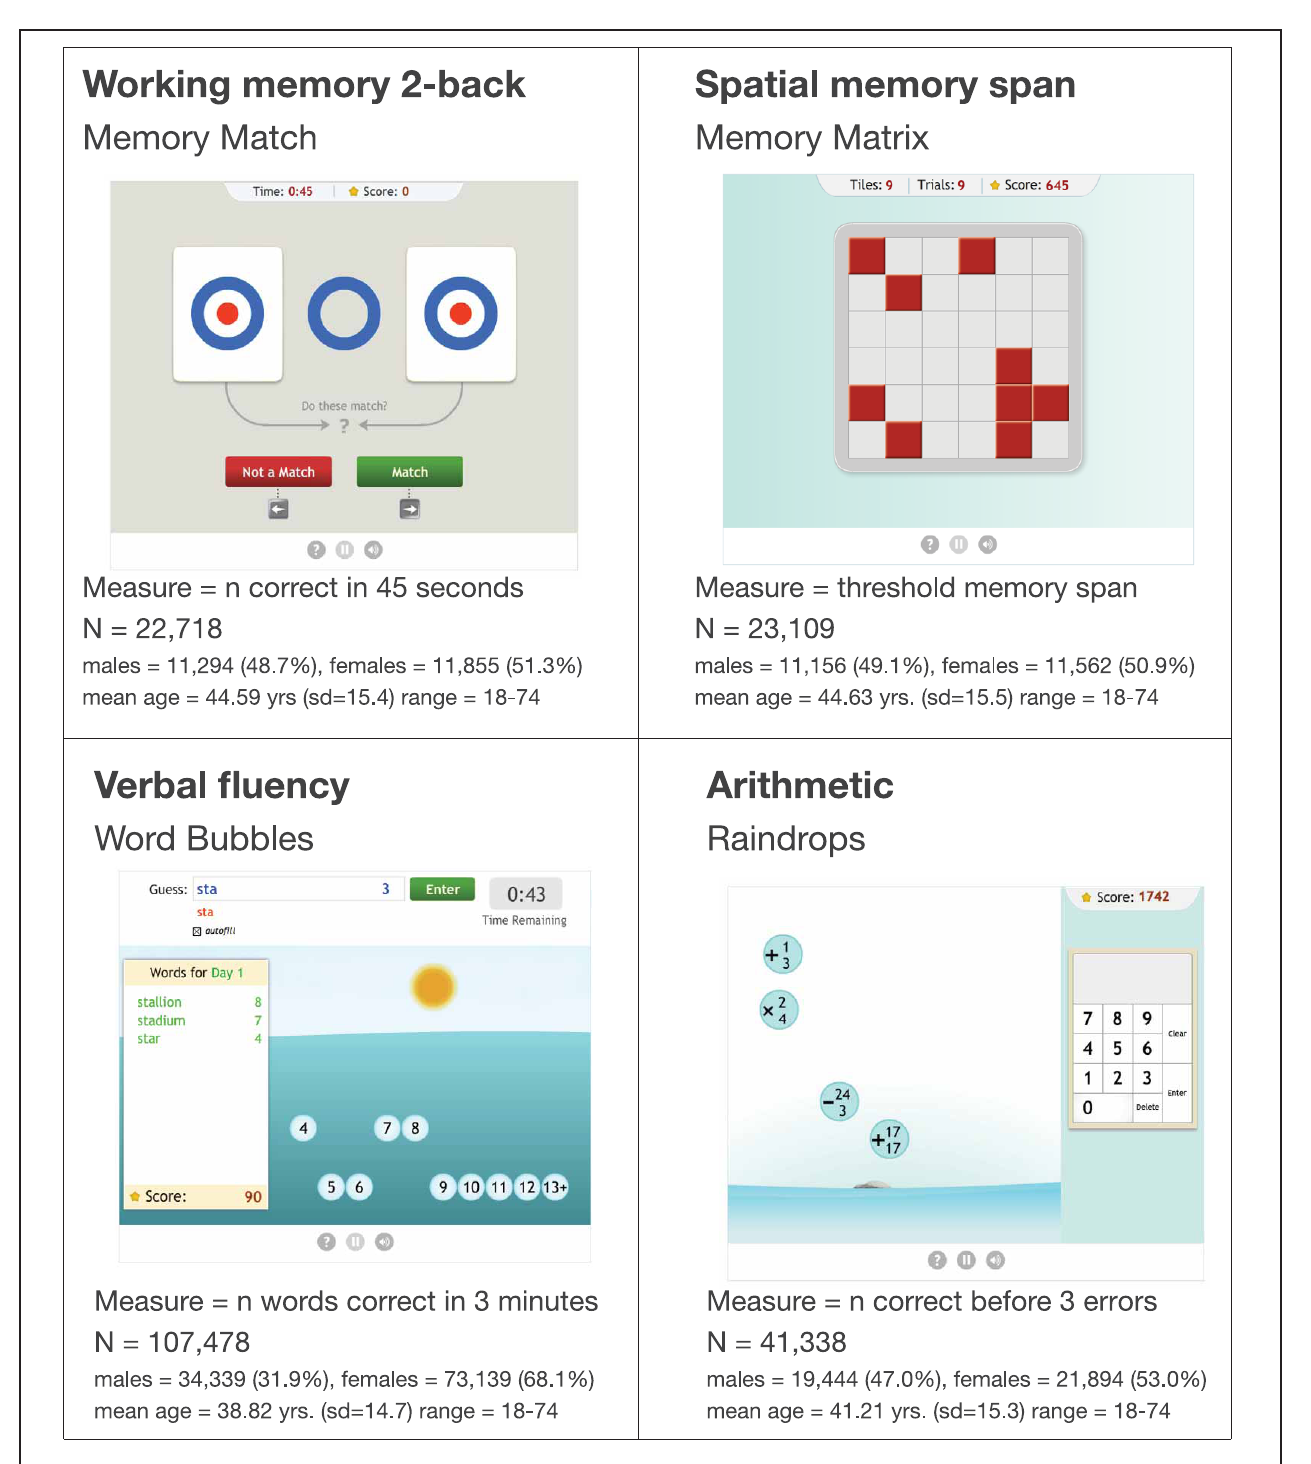
FIGURE 3 | The four exercises used in the aging and learning analysis, and demographic information for each game.